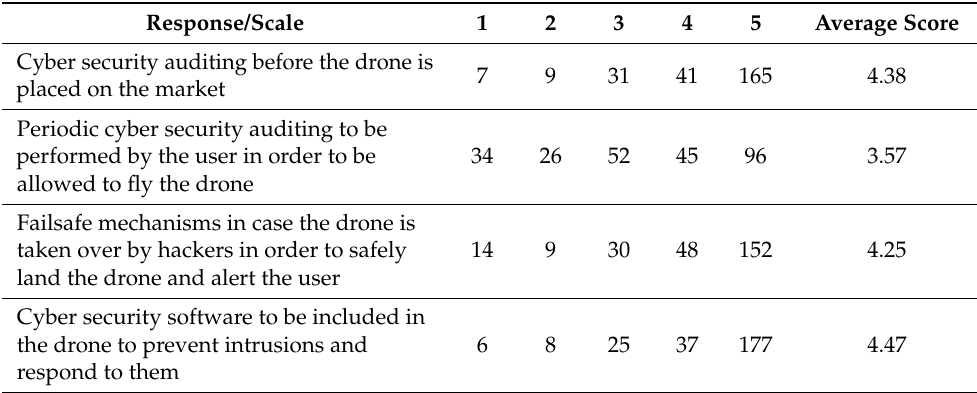
Table 2. Preventive measure for outset